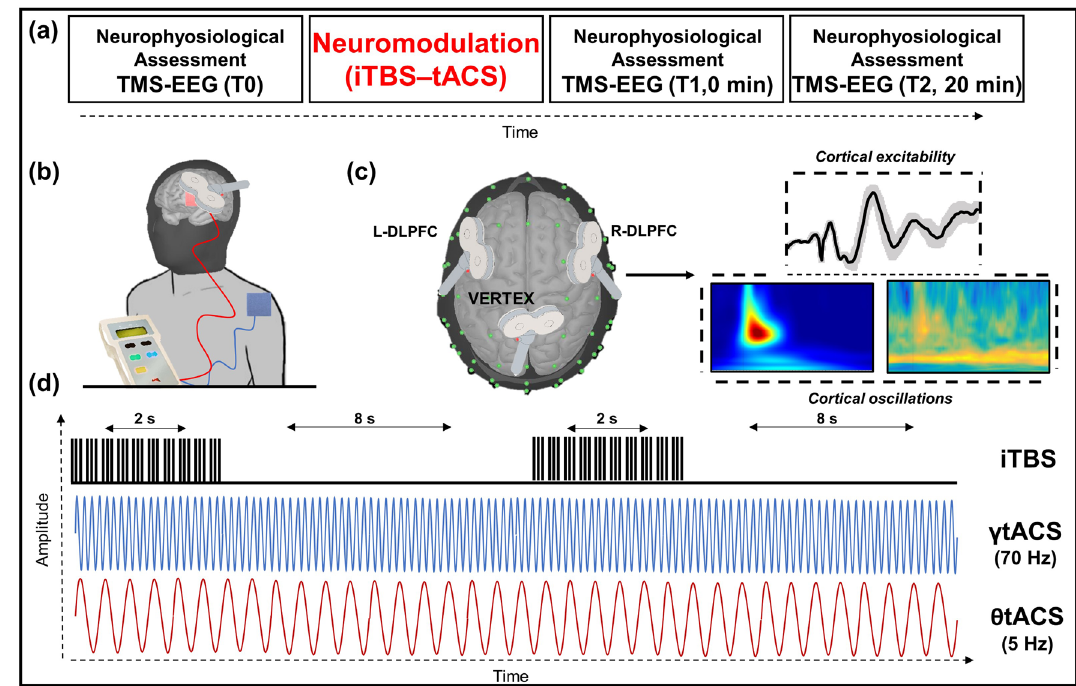
Figure 7. ( a ) Single experimental session design; iTBS–tACS neuromodulation effects were assessed before, at 0 min, and 20 after the stimulation. ( b ) Focus on the iTBS–tACS on left dorsolateral prefrontal cortex (l-DLPFC). ( c ) Focus on the three sites stimulated to assess the effects of stimulations with TMS-EEG. Next to the sites figures are an example of domains interested by the analysis. ( d ) Stimulation protocols example for intermittent theta burst stimulation (iTBS) and both gamma (γ) and theta (θ) transcranial alternated current stimulation (tACS). iTBS delivered triplets of magnetic pulses that last for 2 s with an interval of 10 s between stimulation trains; tACS delivered electrical stimulation waves at 70 Hz or 5 Hz depending on the experimental